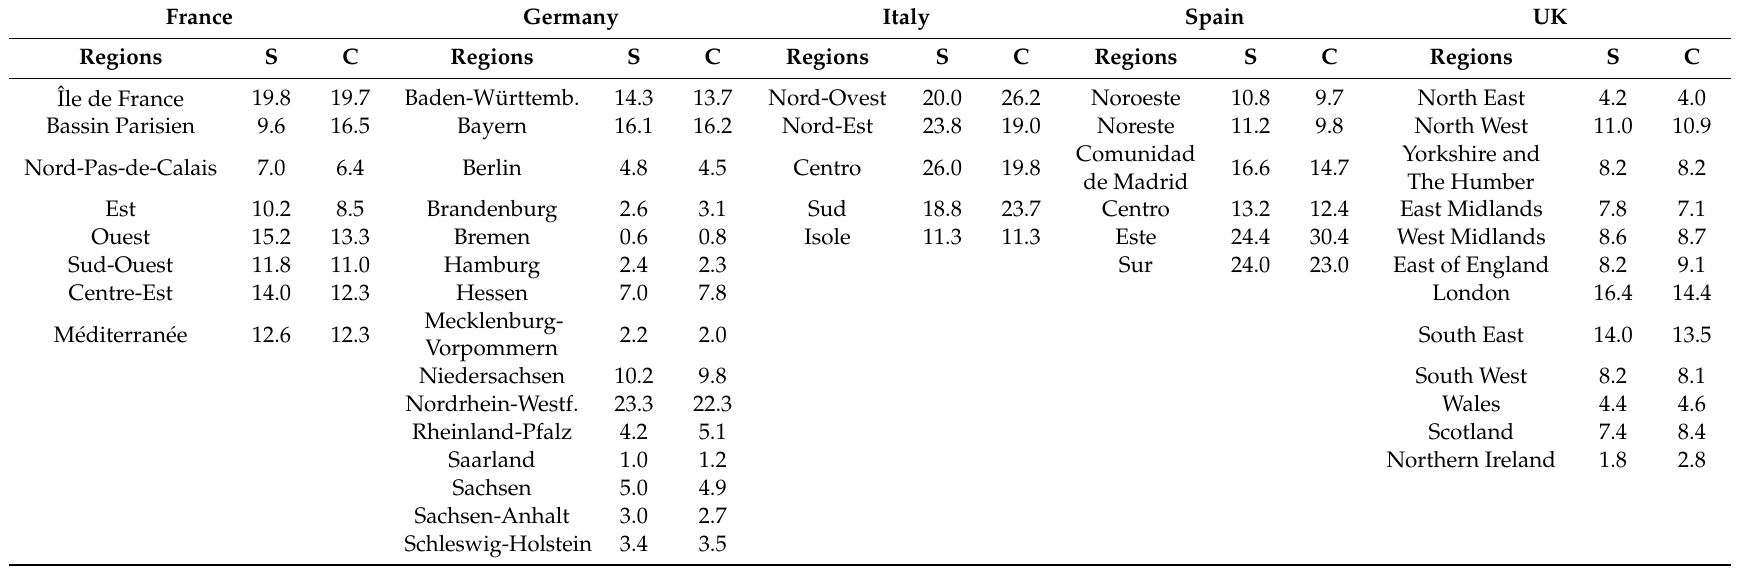
Table A2. Sample (S) and national census (C) by Region (in %).